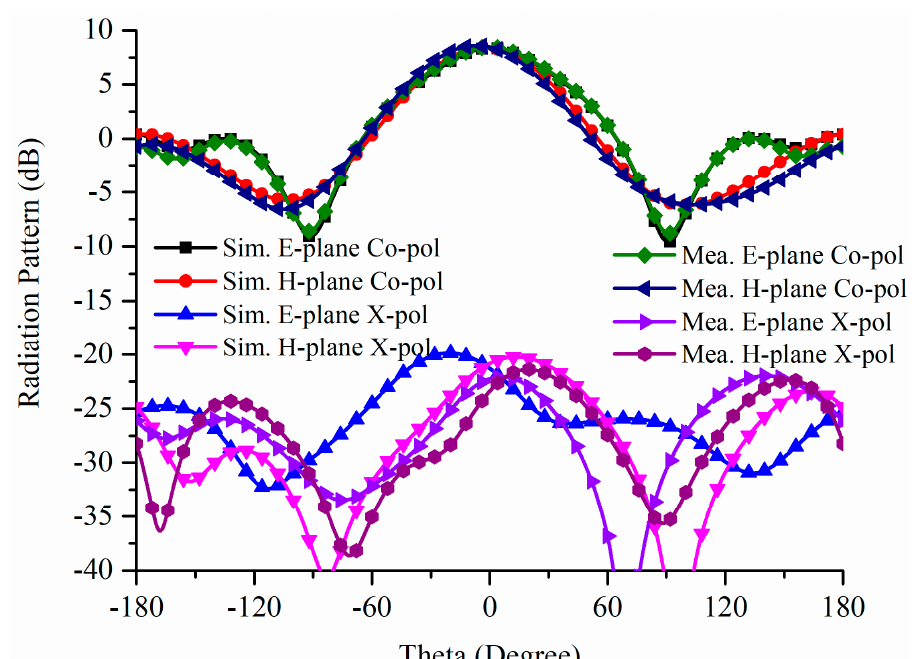
Figure 13. Simulated and measured radiation patterns at 5.85 GHz when Port 1 is excited.